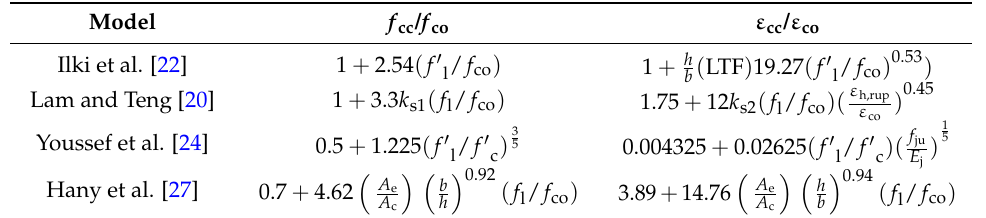
Table 6. Expressions for FRP-confined concrete strength and ultimate strain. LTF, loading type